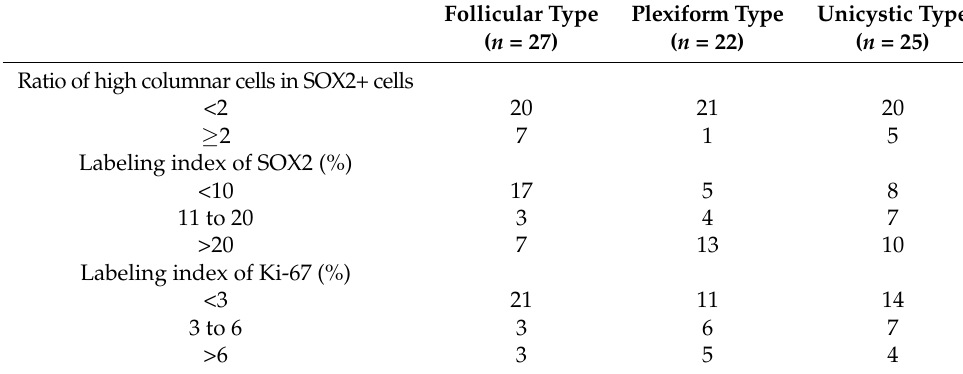
Table 3. Immunohistochemistry in three histologic patterns of ameloblastoma.